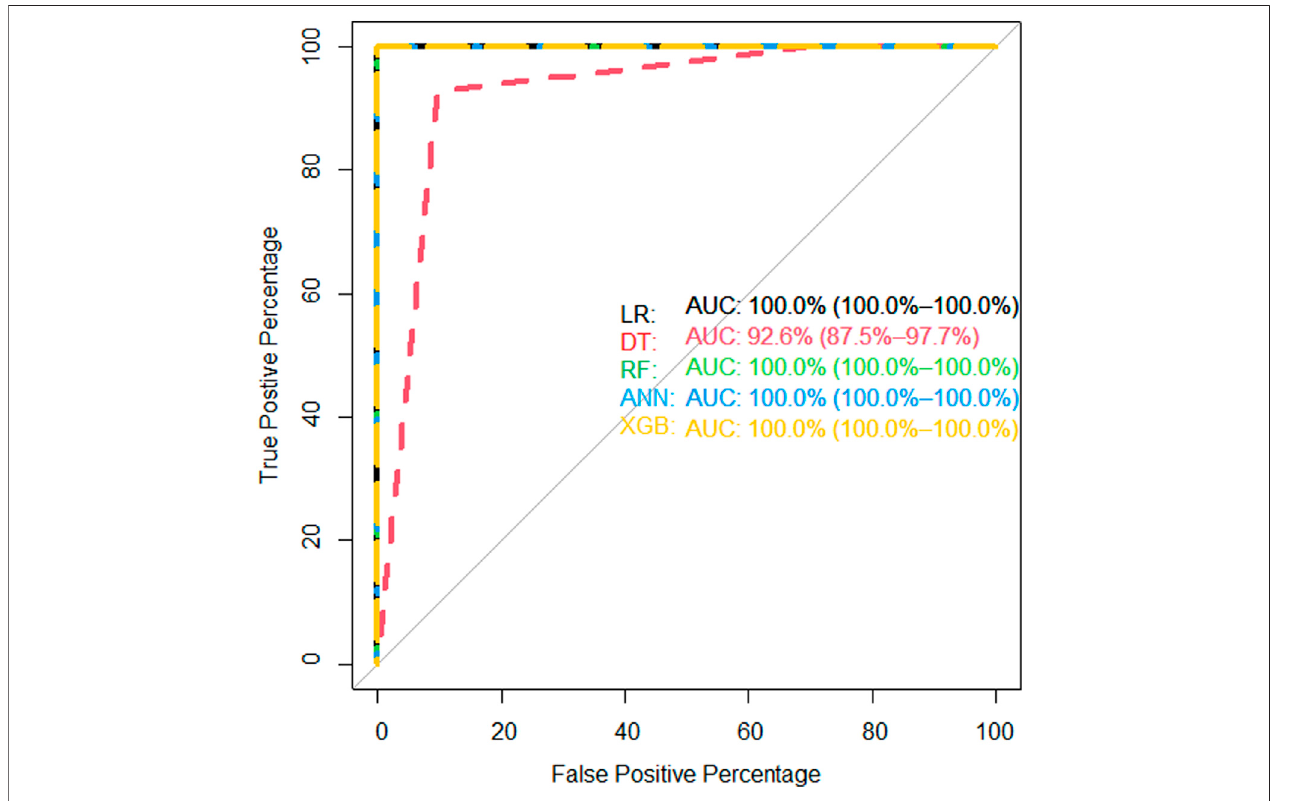
FIGURE 5 | AUC of proposed models of all identi fi ed microRNAs in the internal (GSE106817) validation